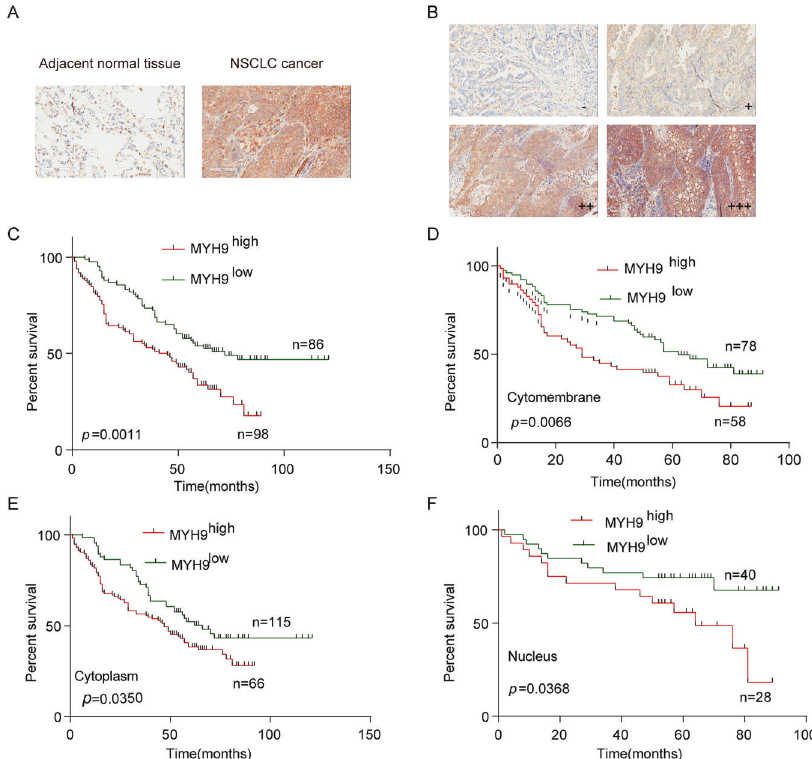
Fig. 6 MYH9 is an independent risk factor in patients with NSCLC. A Expression of MYH9 in NSCLC and paracancerous tissues (scale bar, 100 μ m). B IHC divided the expression of MYH9 in lung cancer into four grades: negative ( – ), weakly positive ( + ), positive ( ++ ), and strongly positive ( +++ ) (scale bar, 100 μ m). C Kaplan-Meier survival curve of overall survival in patients with NSCLC (** p < 0.01; Log-rank test). D , E Kaplan-Meier survival curve and univariate analysis were used to study the correlation between MYH9 expression in the cell membrane, cytoplasm, nucleus, and survival prognosis in patients with NSCLC (* p < 0.05and ** p < 0.01; Log-rank test).